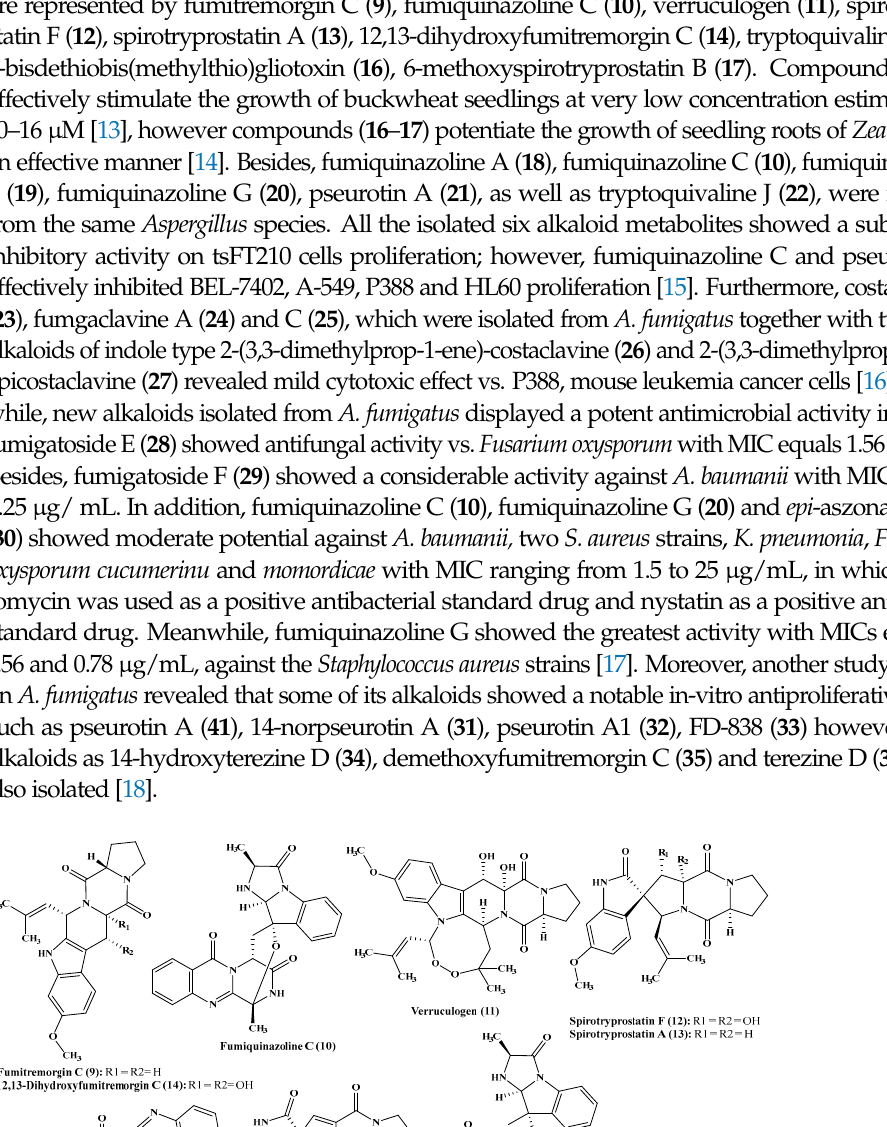
Figure 3. Alkaloids isolated from Aspergillus fumigatus (cont’d).